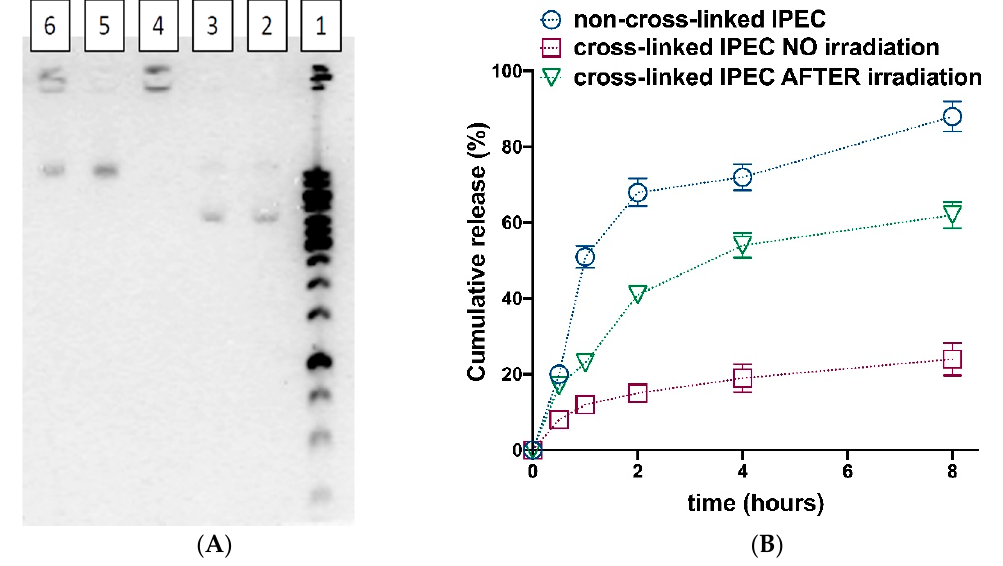
Figure 8. Photosensitive release studies: ( A ) Release of pDNA (pCLuc4) detection via agarose gel electrophoresis: (1) ladder; (2, 3) pDNA; (4) pDNA in cross-linked IPECs ([Lys–NH 3+ ]:[pDNA– PO 4 − ]:[Hep–SO 3 − ]:[linker] = 1:0.5:3:0.8) without UV treatment; (5) pDNA in cross-linked IPECs ([Lys–